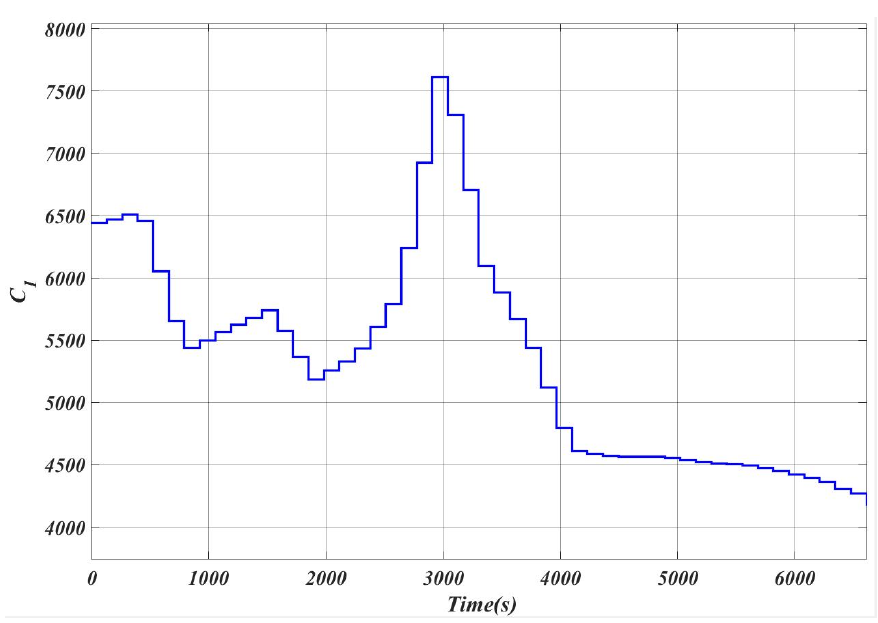
Figure 16. C 1 vs. Time.